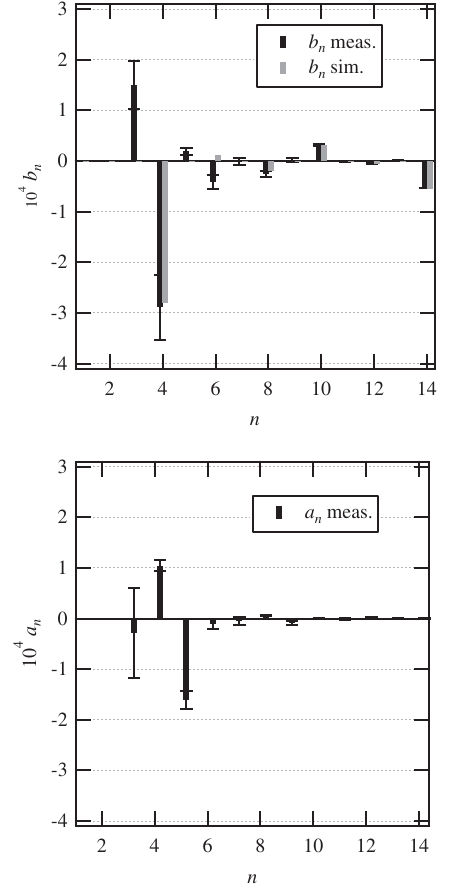
FIG. 18. Higher order multipoles of the high gradient quadru- pole prototype at 90 A and expressed at 7 mm radius. Circular measurements at different radii, ranging from 5 mm up to 12 mm, have been combined for measuring the multipoles. The standard deviations have been computed at only one radius, which is a pessimistic case. The dipole and quadrupole terms are not shown. The simulations are for interpole distances with errors equal to (cid:3) 0 . 020 mm (depending on the pole), with a symmetry that does not allow sextupole